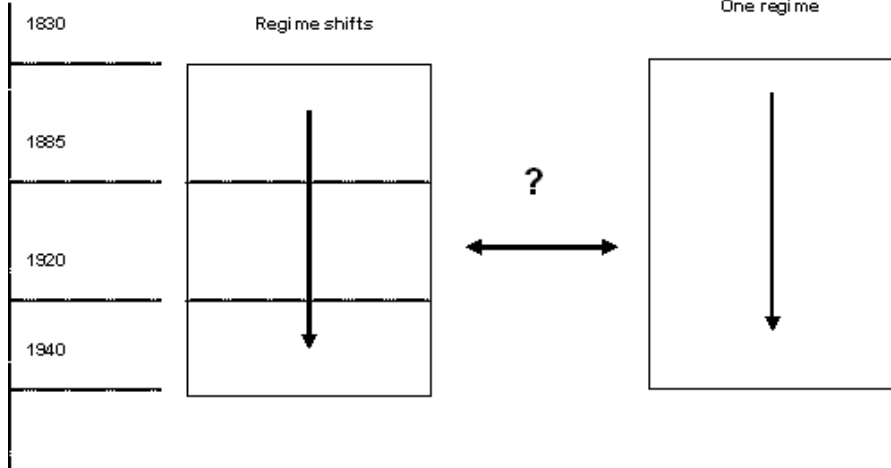
Figure 5 Two regime development points of